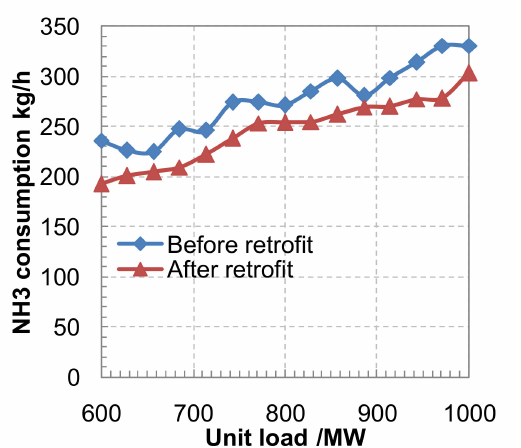
Figure 11. Comparison of the ammonia consumption before and after implementing the technology in a 600-MW